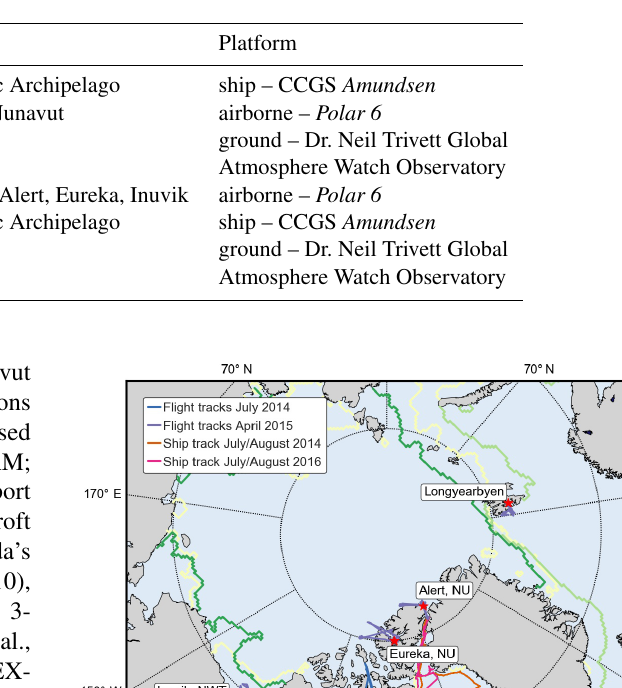
Table 1. NETCARE Arctic field campaigns.